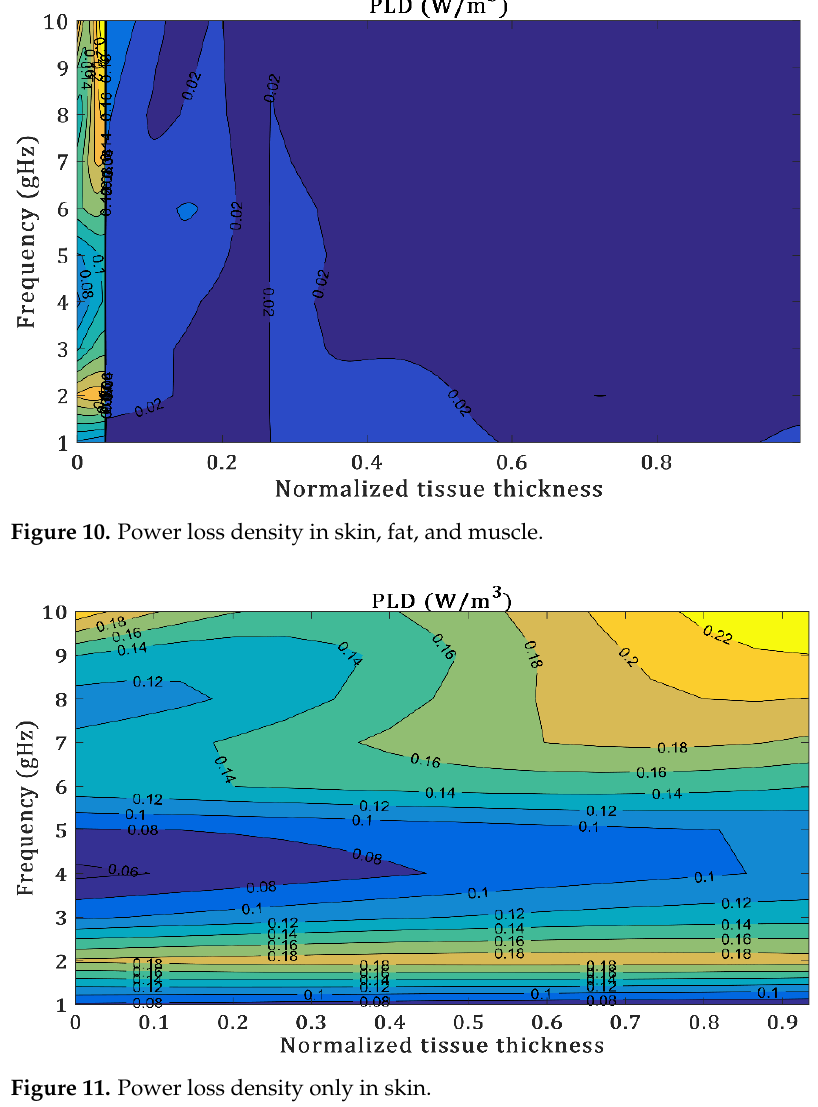
15 of 18 Table 4. Propagation scenarios. Communication Scenario (dB)